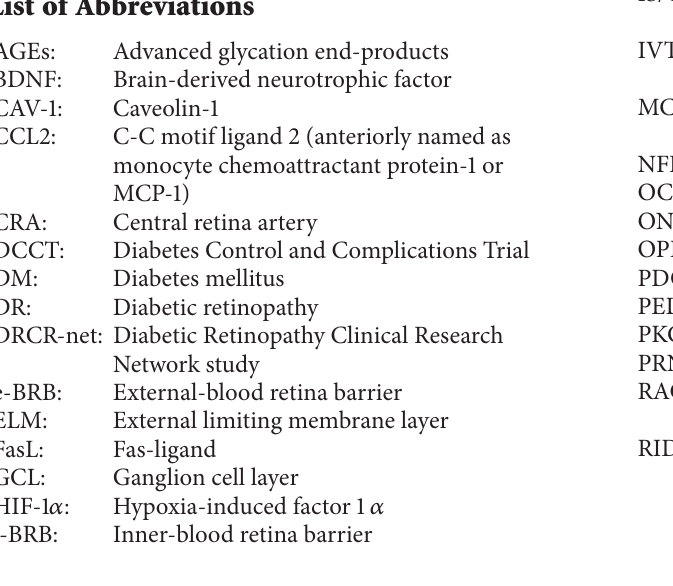
identified relevant articles, which were later confirmed. The citations from these articles were also used to identify articles not found with the above search terms. Any non-English references were